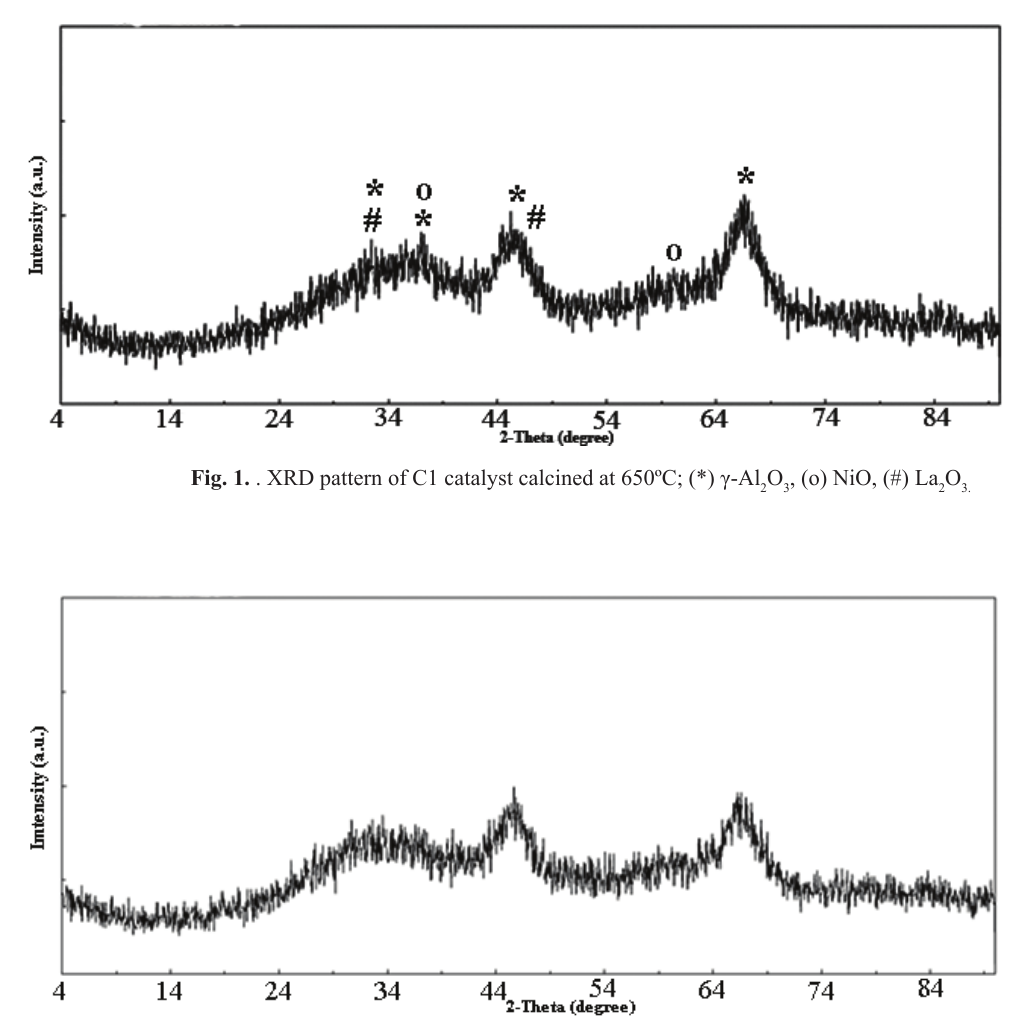
Fig. 2. XRD pattern of C2 catalyst calcined at 650ºC.